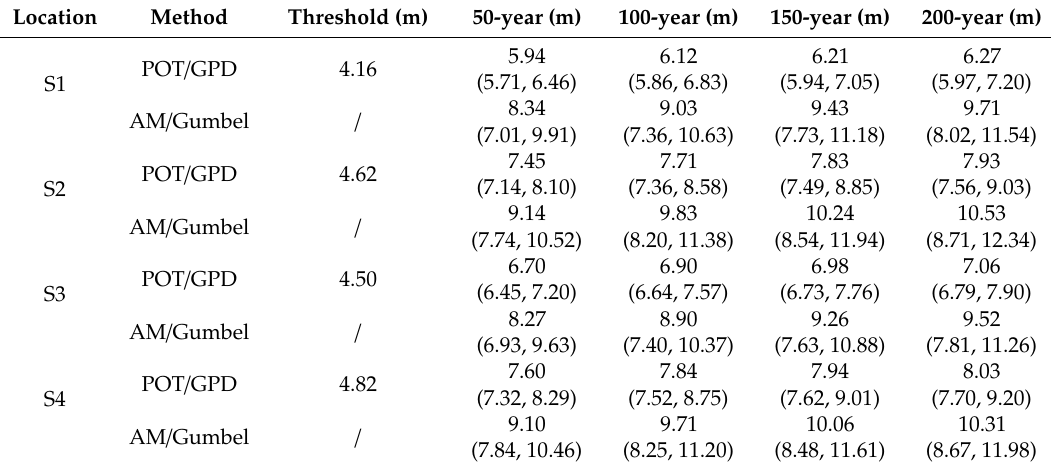
Table 1. Return significant wave heights in the North at four study